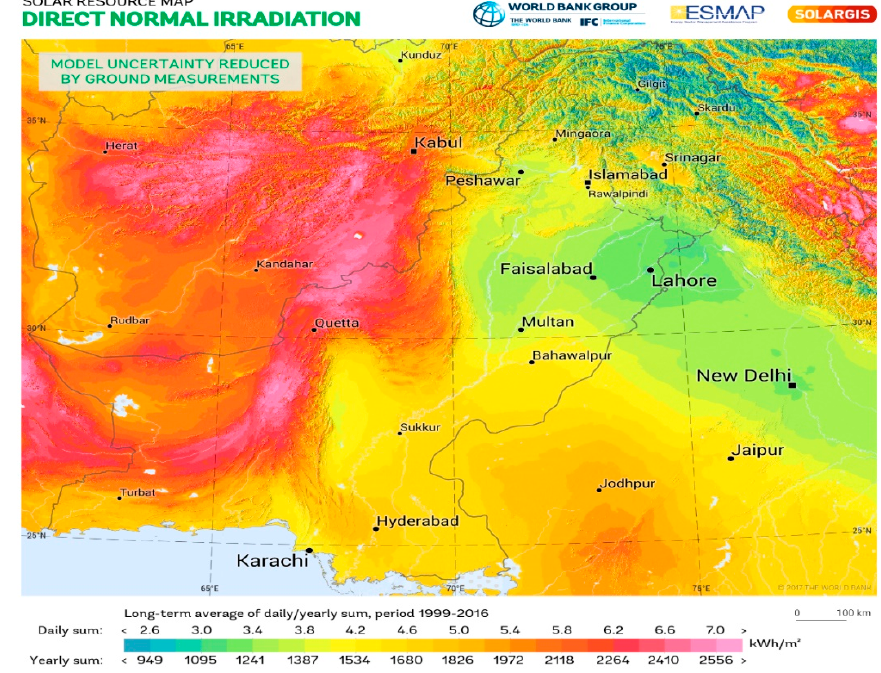
Figure 9. Annual direct normal irradiation (DNI) in Pakistan.